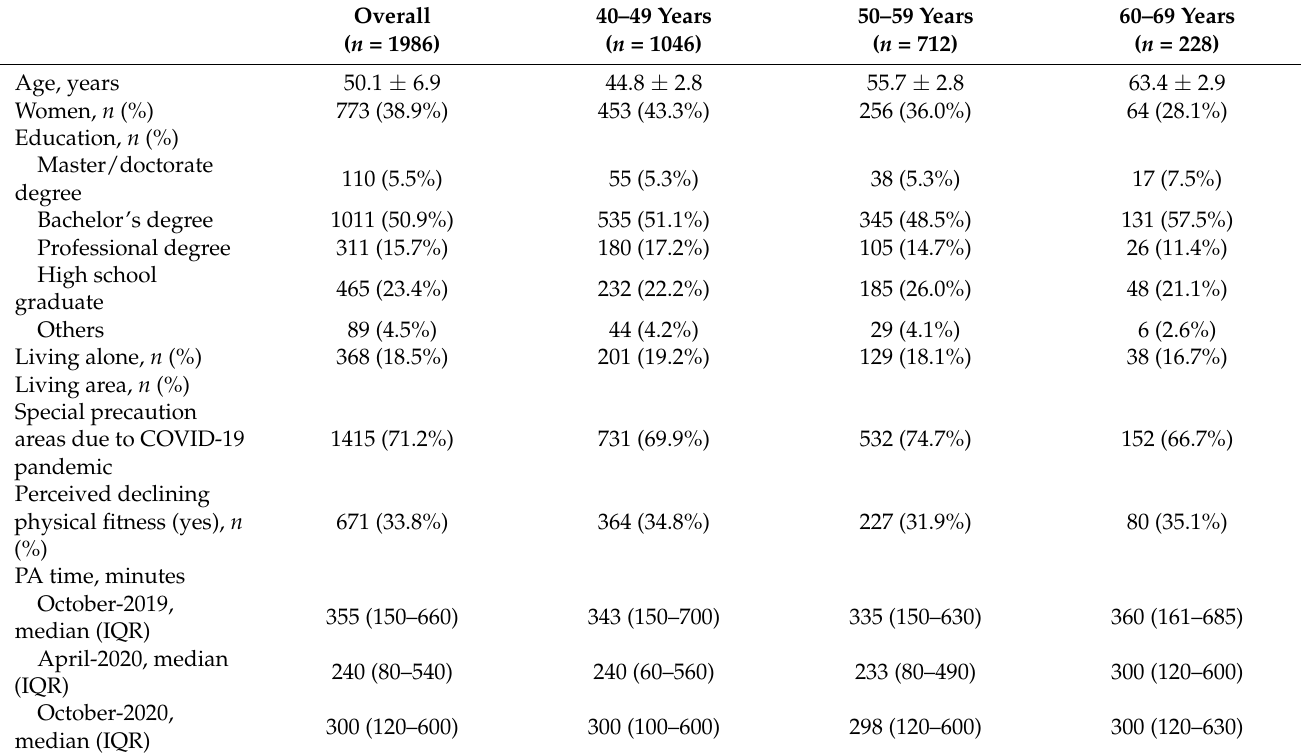
Table 1. Demographic characteristics and physical activity (PA) time of the participants in each age